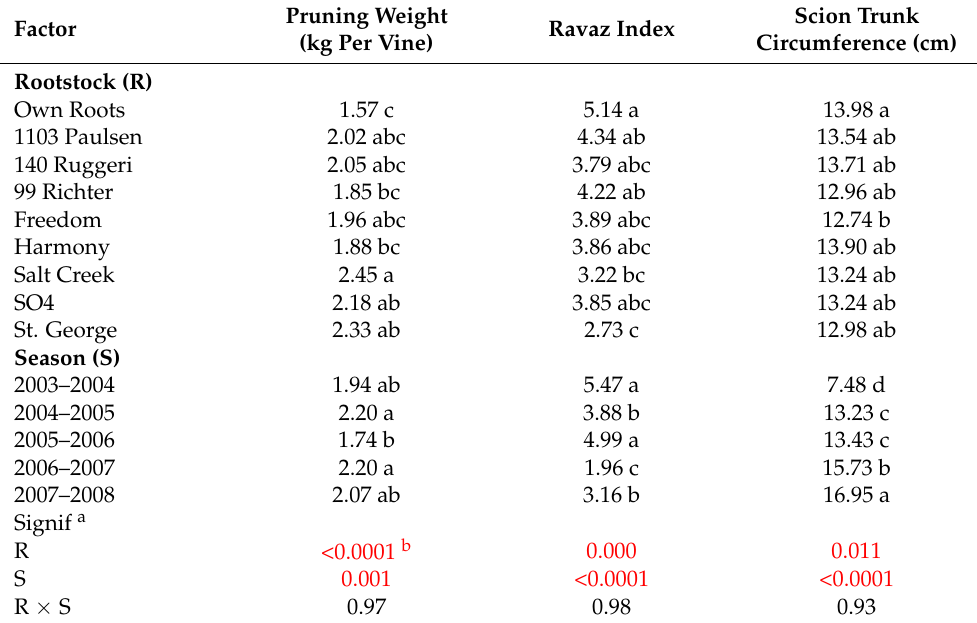
Table 4. Effect of rootstock on vine vigor, vine balance, and scion trunk circumference of Syrah grapevines growing under hyper-arid conditions over five consecutive